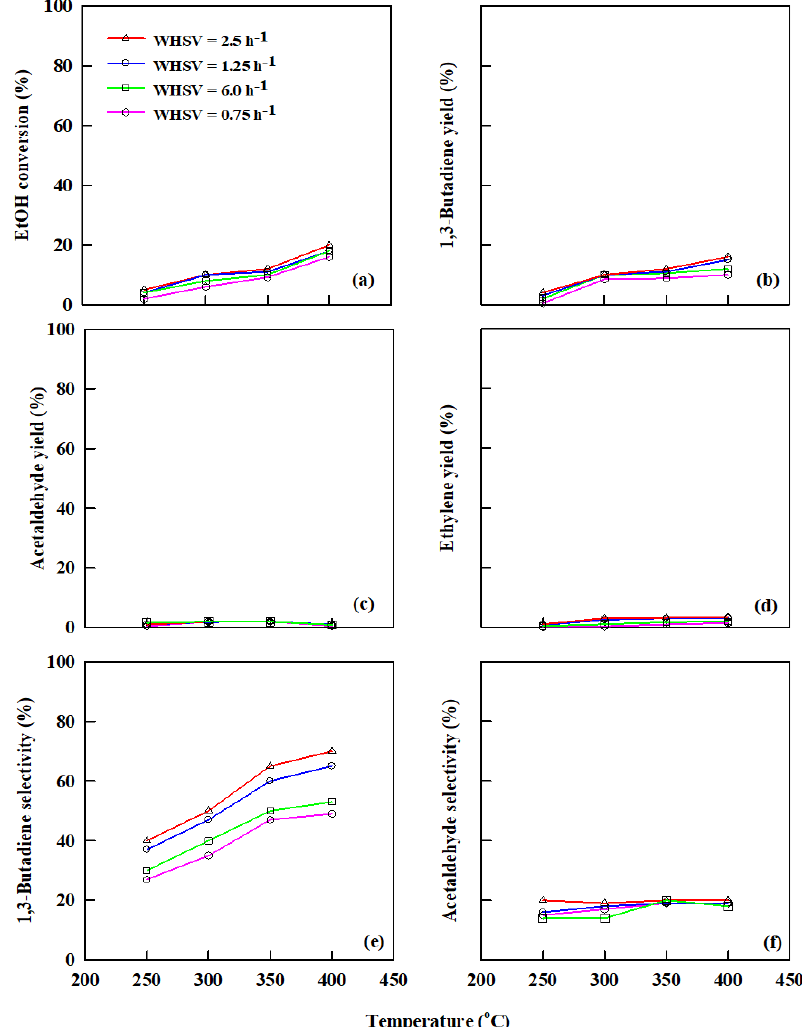
Figure 5. Plot of the ash catalyst ( a ) ethanol conversion, ( b ) yield of 1,3-butaiene ( c ) acetaldehyde yield ( d ) ethylene yield ( e ) 1,3-butadiene selectivity and ( f ) acetaldehyde selectivity at different reaction temperatures and WHSV. Catalyst: 0.4 g, WHSV = 0.75–6.0 h −1 , N 2 : 30 mL/min Figure 6 highlights the use of ash in combination with MgO (1:1). This combination achieved an ethanol conversion of 60% at 350 °C and 2.5 h −1 . At a WHSV of 2.5 h −1 and 1.25 h −1 , the ethanol conversion rate was 60% and 57%, respectively. At 6.0 h −1 and 0.75 h −1 , the ethanol conversion decreased to 40% at 350 °C. However, ethanol conversion reached a static constant in the range of 45–40% at 400 °C.